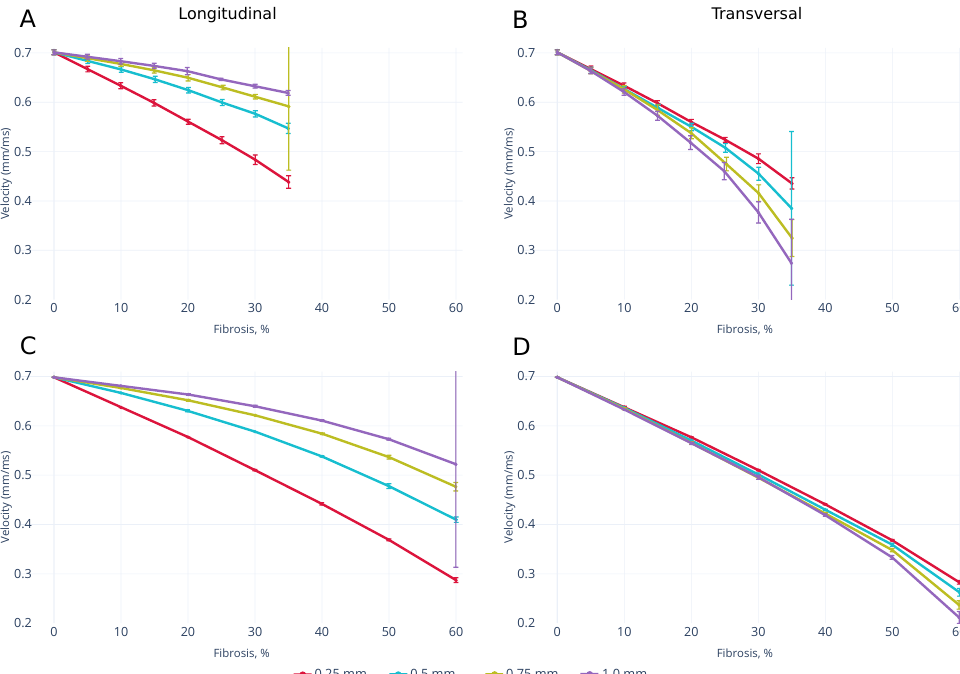
Figure 4. Conduction velocity (CV) depending on the fibrosis area in the longitudinal (left) and transversal (right) wavefront directions in a 3D monolayer of 0.25 mm depth (upper, A , B ) and a multilayer myocardial slab of 2.50 mm depth (middle, C , D ). Error bars show the standard deviation (STD) of the CV in 20 fibrosis pattern samples for each obstacle length. E-F Average wavefront velocities normalized by the values at the diffuse fibrosis of the same percentage for the 3D monolayer (dashed lines) and multilayer models (solid